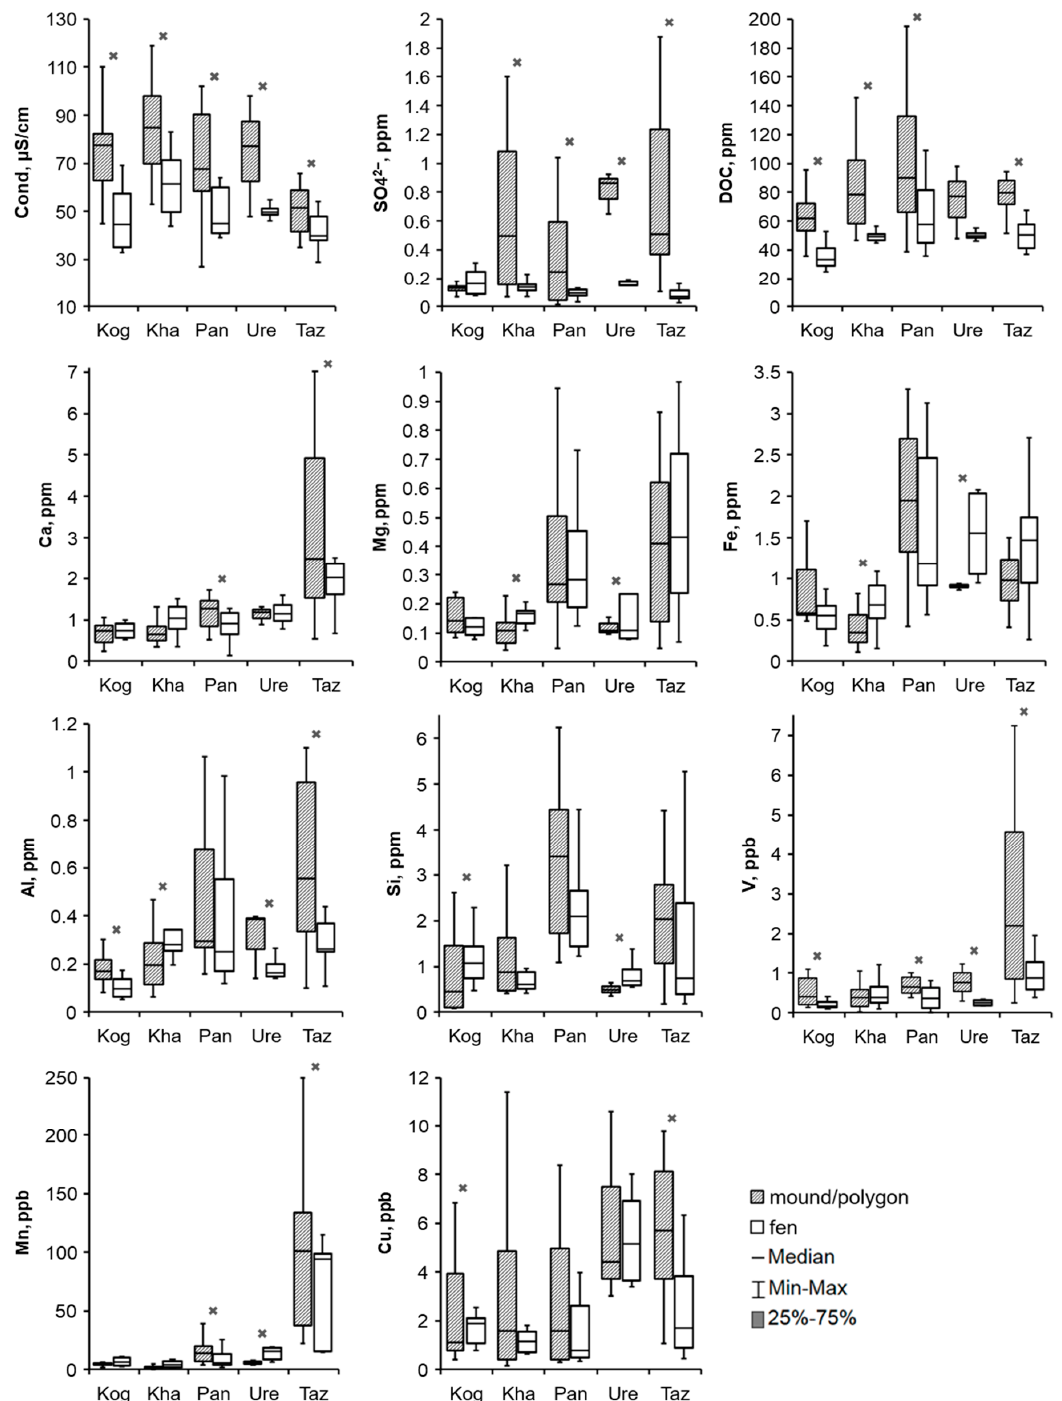
Figure 4. Comparison of the bog water hydrochemical parameters of the different microtopes with significant di ff erences ( p < 0.05) at two or more key sites: Taz—Tazovsky; Ure—Urengoy; Pan significant differences ( p < 0.05) at two or more key sites: Taz—Tazovsky; Ure—Urengoy; Pan —Pangody; Kha—Khanymey; and Kog—Kogalym. An asterisk represents significant di ff erences —Pangody; Kha—Khanymey; and Kog—Kogalym. An asterisk represents significant differences between microtopes, p < 0.05. between microtopes, p <